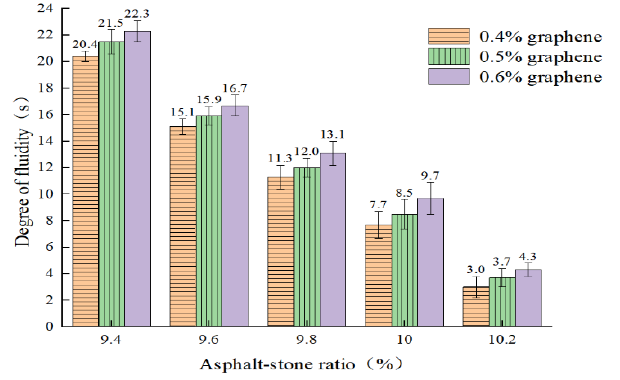
Figure 12. Fluidity test of CGA-10 asphalt mixture with 0.3% carbon fiber content.